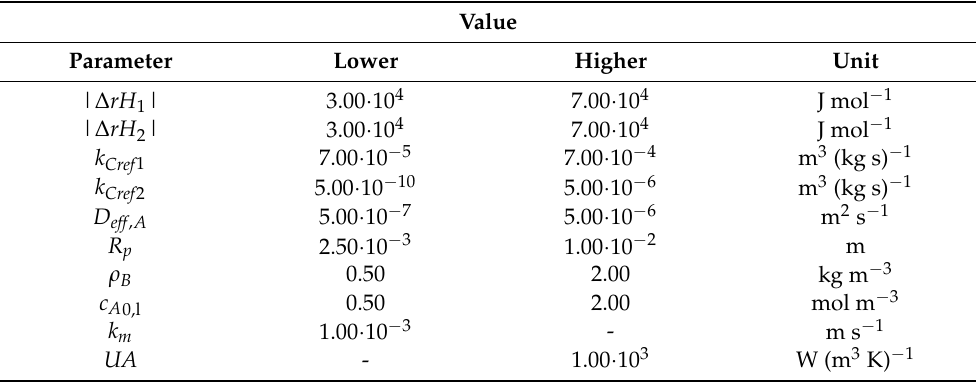
Table 2. Variable parameters compared to the standard